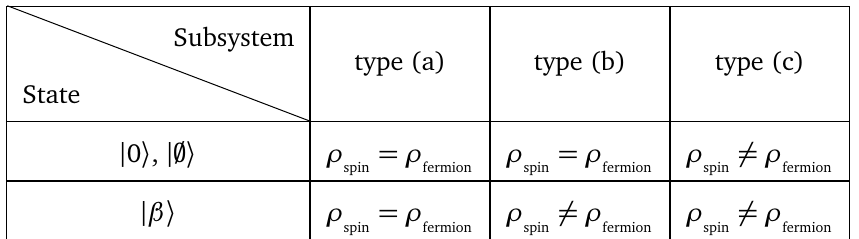
Table 2: A handy representation of the statements in the section 5.5. In the below, ρ stands for the RDM in the spin representation and ρ spin fermionic representation of the Hamiltonian. The subsystem types are demonstrated in figure 1. In addition, we have assumed the restriction on β (cid:54) = 0, ∞